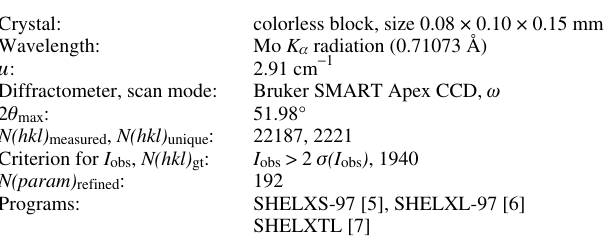
Table 1. Data collection and